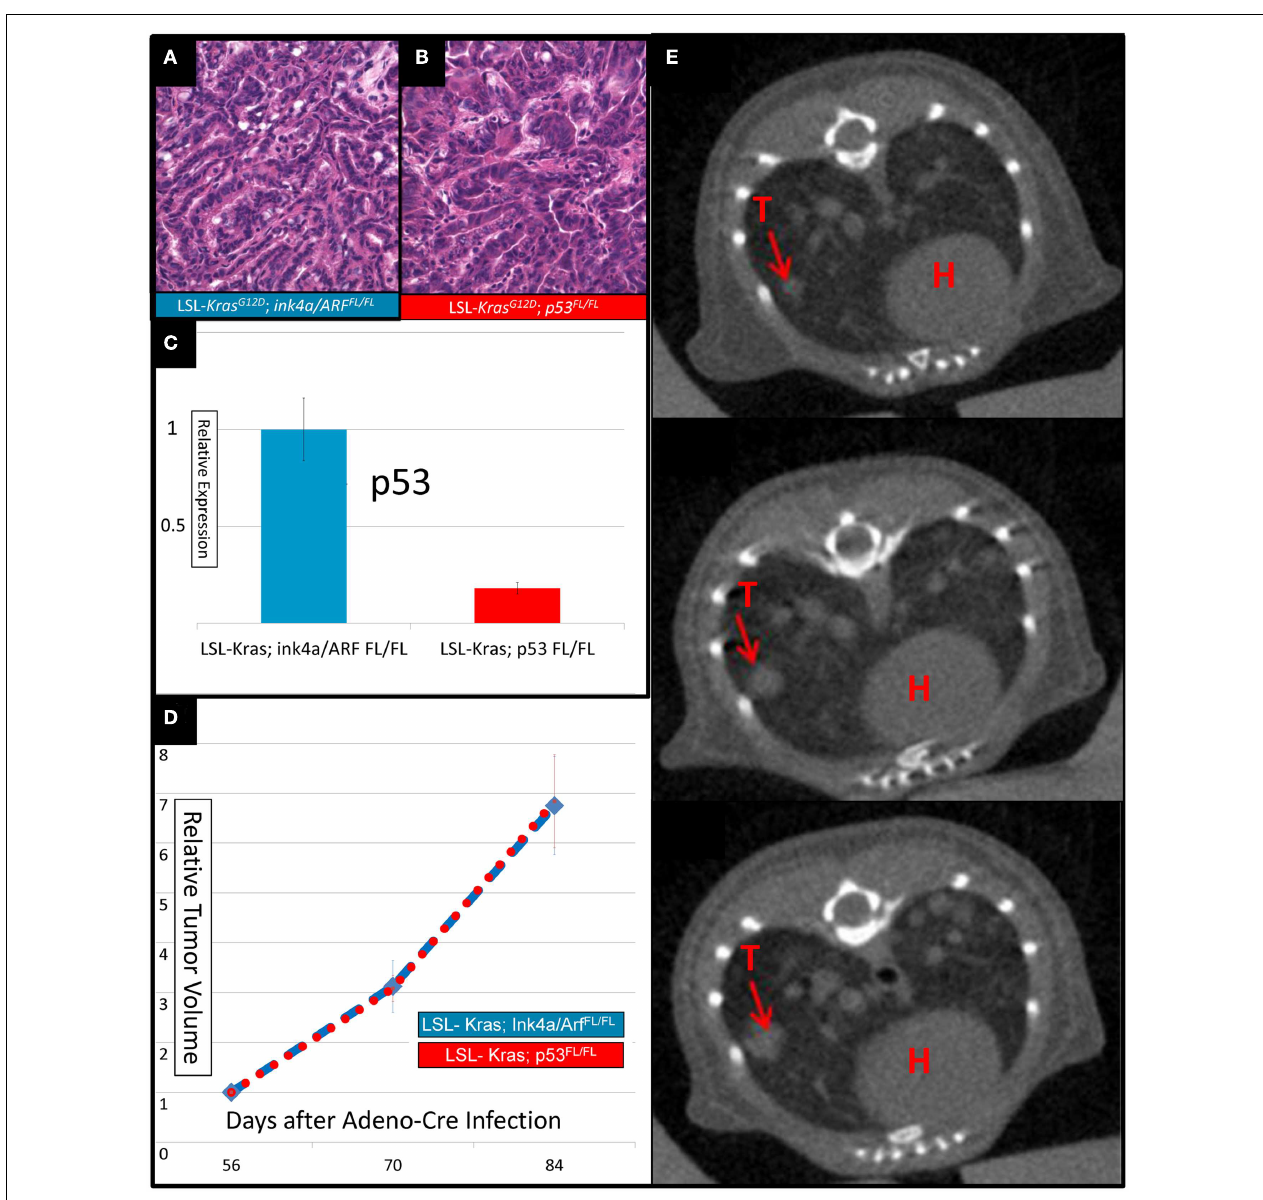
P < 0.0001). (D) Relative tumor growth over time with no treatment demonstrates similar growth rates in each tumor cohort at 56, 70, and 84days following intranasal Adeno-Cre infection. Blue – lung cancers ( n = 27) from LSL-Kras; Ink4a/ARF FL/FL mice, Red – lung cancers ( n = 45) from LSL-Kras; p53 FL/FL mice. (E) Serially reconstructed Micro-CT scans at 56, 70, and 84days after Adeno-Cre infection from a LSL-Kras; p53 FL/FL mouse documents clear and measurable tumor growth over time.T, tumor; H, heart. Error bars –